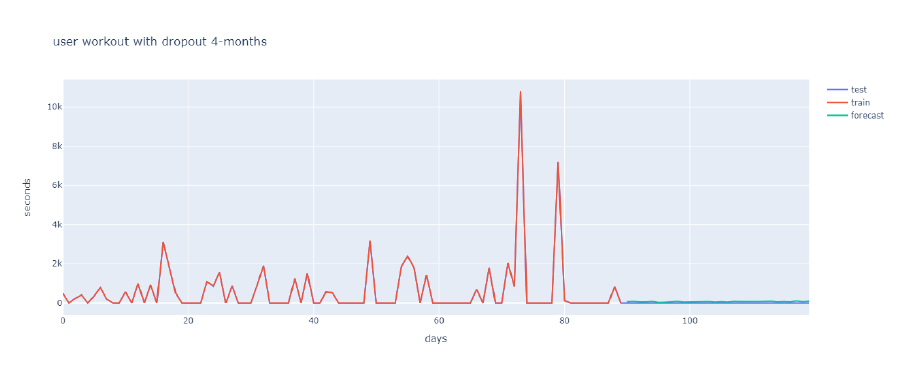
Figure 12. User 2 workout behaviour (four months).